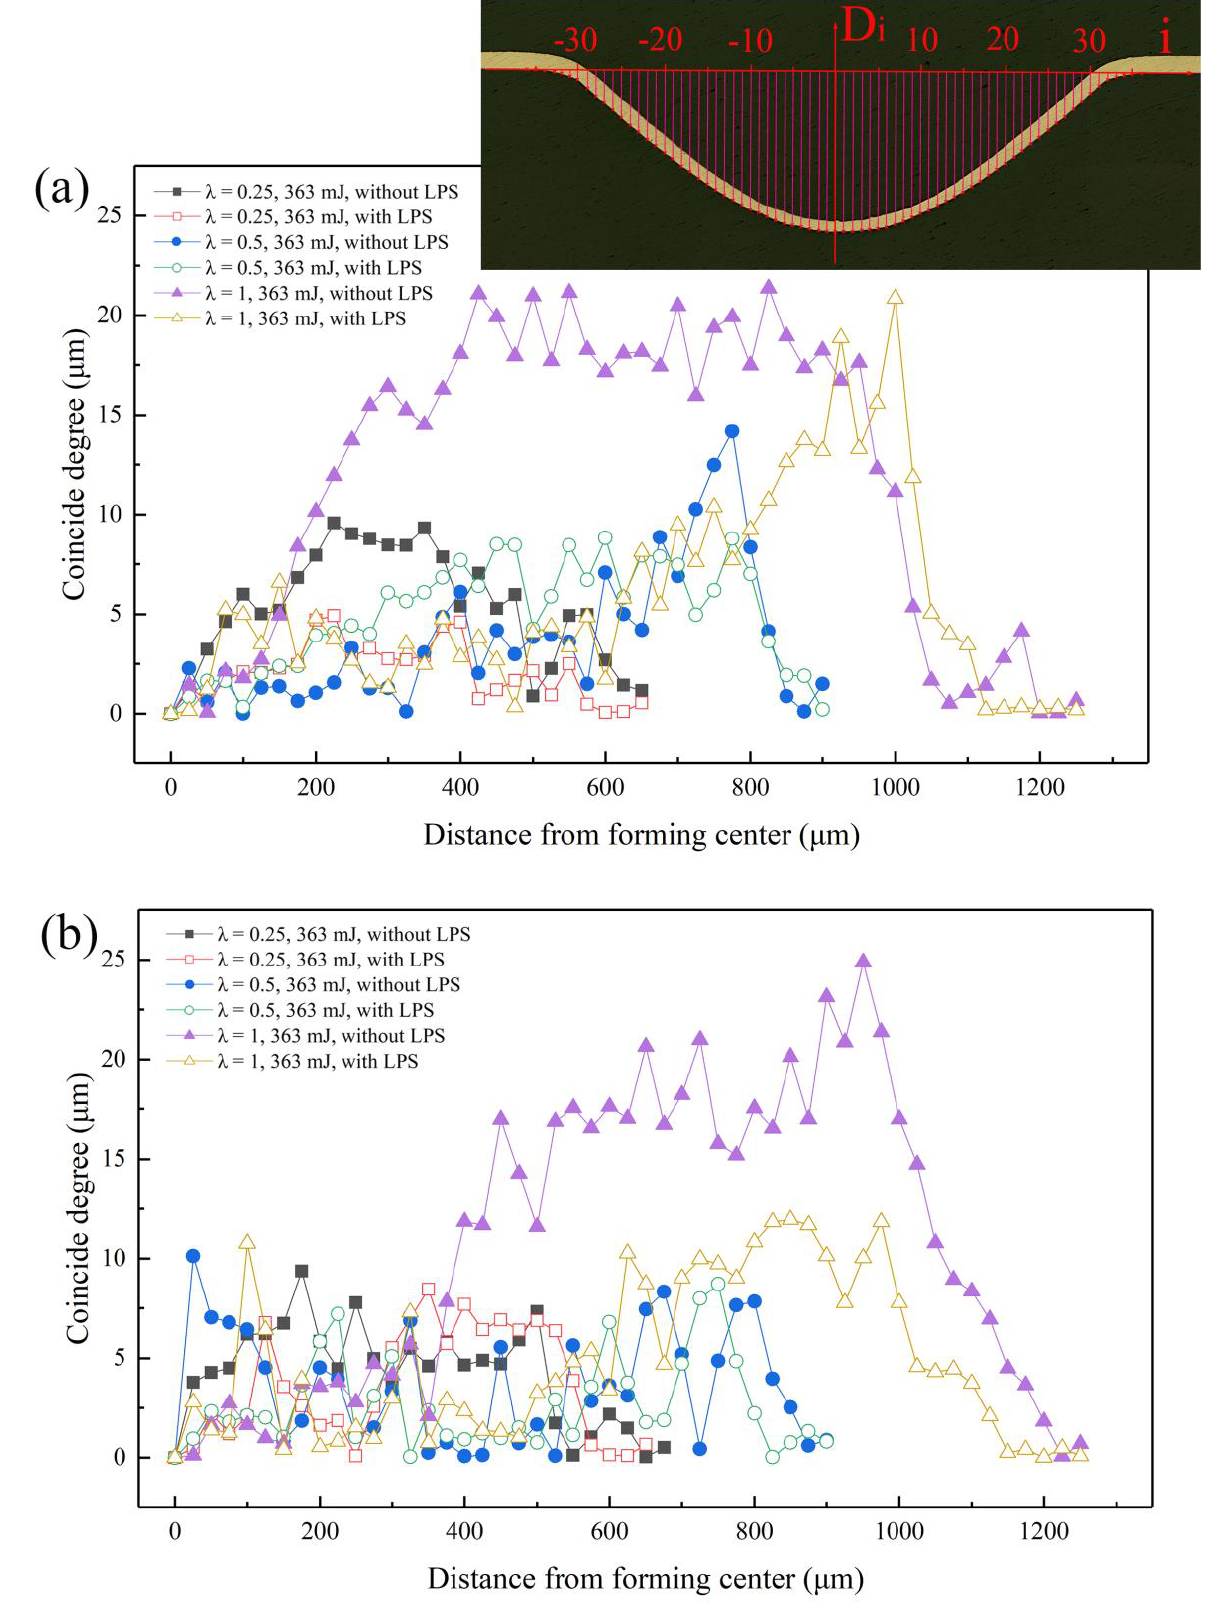
Figure 12. Effect of mold characteristic size on the coincidence degree C of bulging samples under laser pulse energy of 363 mJ. ( a ) 450 ◦ C annealed; ( b ) 650 ◦ C